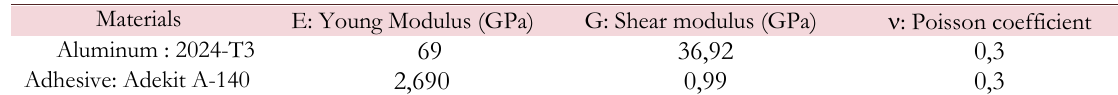
Figure 2: Some positions of adhesive defect.